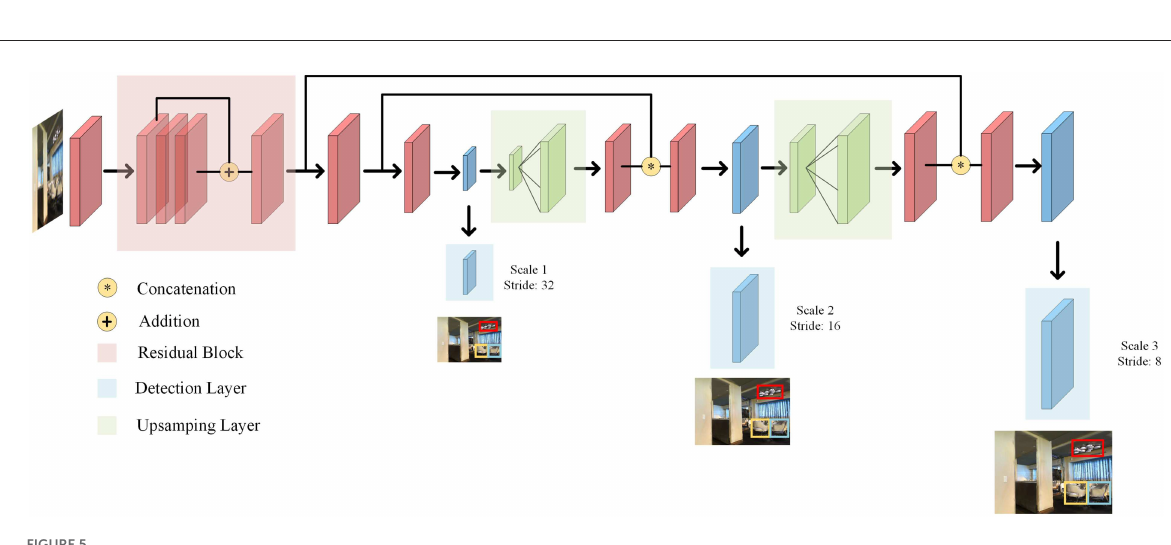
FIGURE5 Scheme of the proposed architecture for